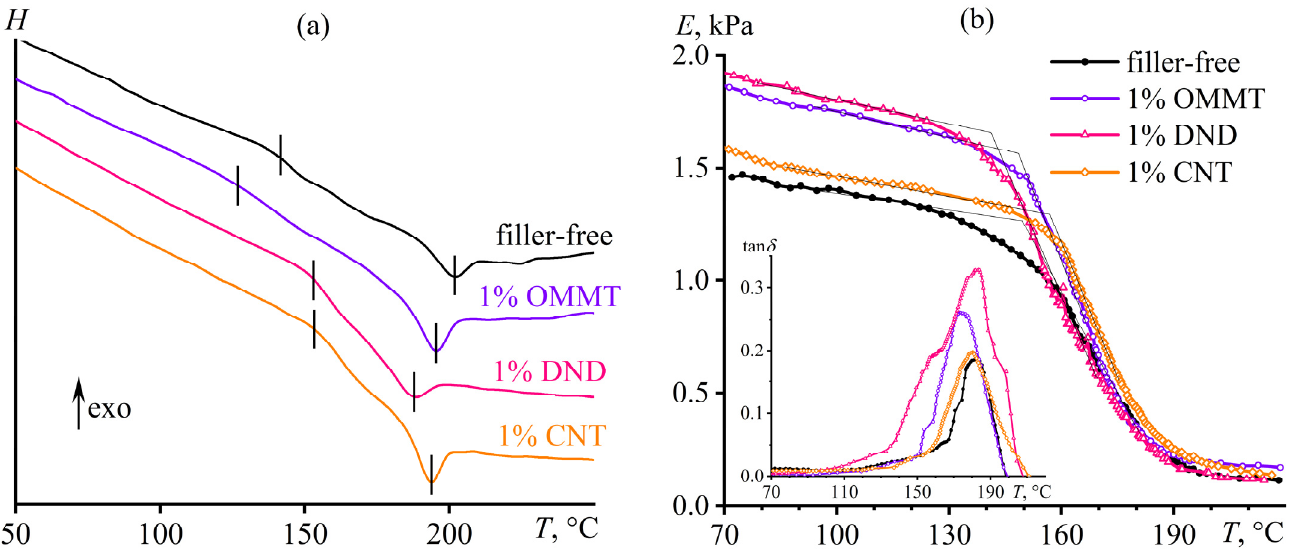
Figure 13. DSC ( a ) and DMA ( b ) curves for cured fiber-free epoxy binder ( a ) and carbon-fiber-reinforced composite ( b ). The vertical lines ( a ) mark the glass transition range, while the tangents to the temperature dependences of the rigidity modulus ( b ) indicate the onset temperature of its drop. The inset ( b ) shows the temperature dependence of the loss tangent for the same samples.